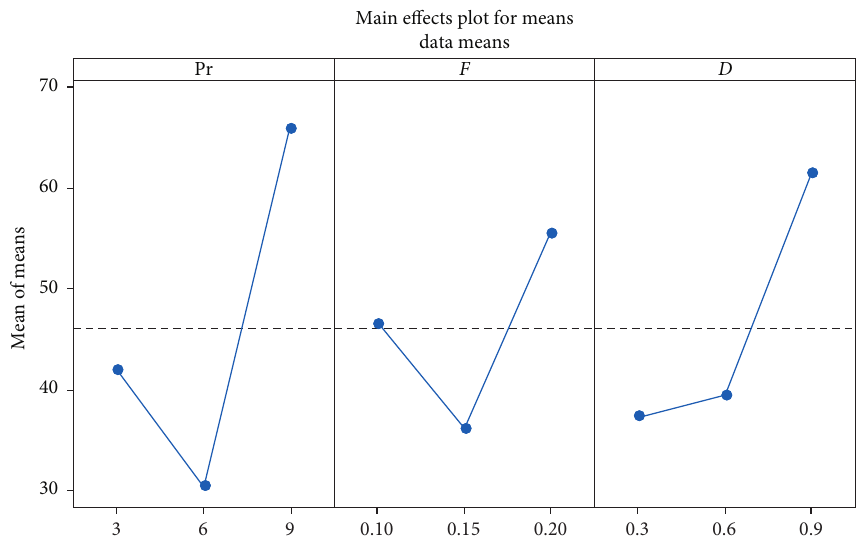
Figure 9: Thrust force-based important diagram based on the means; in the X -axis, Pr denotes pressure of cutting fluid (bar), F denotes feed (mm/rev), and D denotes depth of cut (mm).